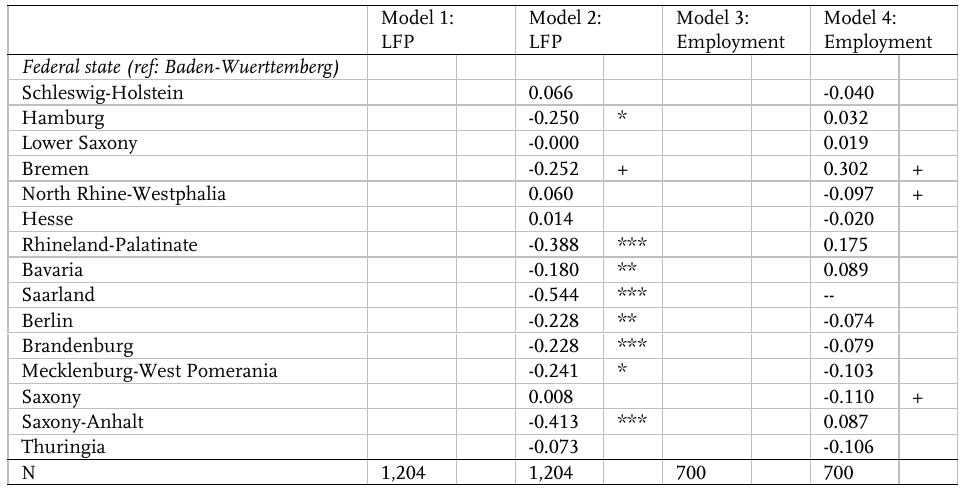
Table A.3 : Results from logistic regression (1: Labour market participation; 0: No labour market participation), pooled models and models by gender, average marginal effects (AME)